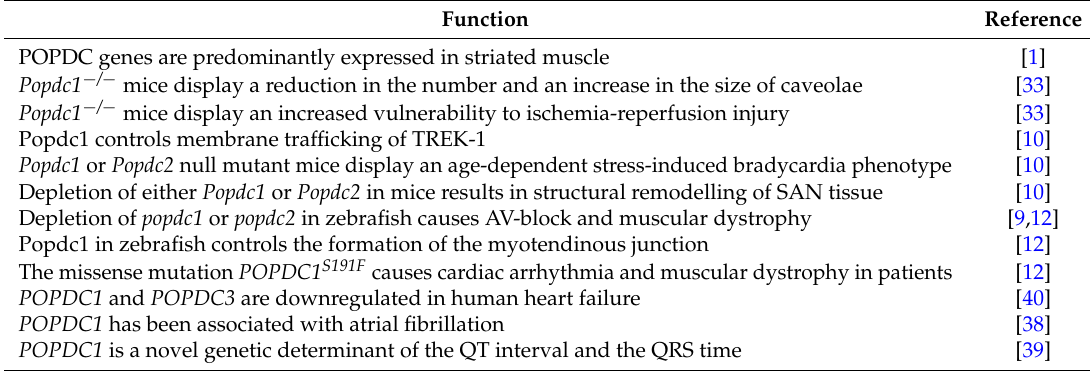
Table 1. Cardiac and skeletal muscle functions of Popdc